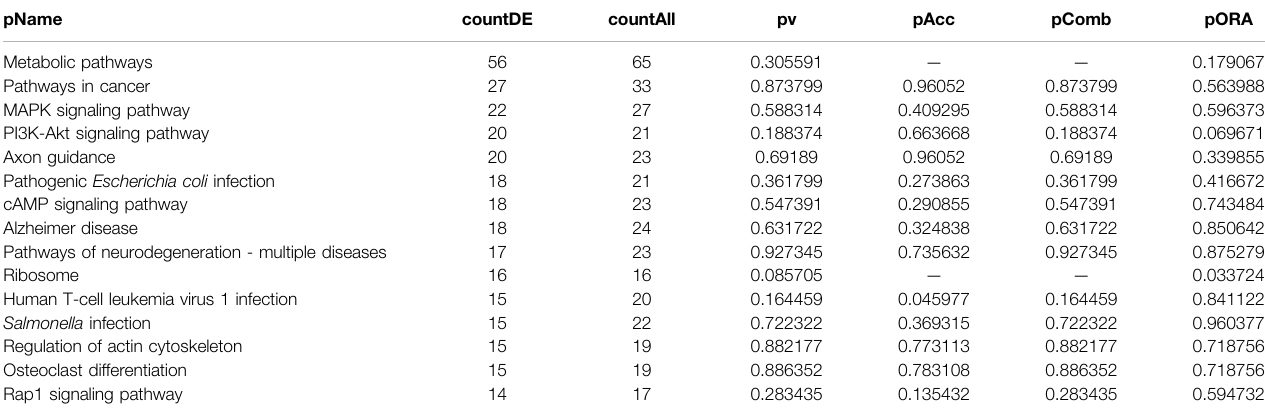
TABLE 4 | Top 15 pathways ranked based on their associated differentially expressed genes derived from astrocytes based on the comparison AD00206 (disease) vs. AD00201 (control).